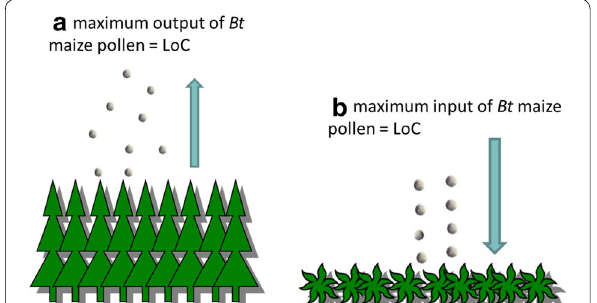
Fig. 3 Suggestions for the operationalisation of the LoC concept for non-target lepidopteran larvae and Bt maize. The LoC can be defined for the exposure-based indicators ( a ) “amount of Bt maize pollen released” or ( b ) “amount of Bt maize pollen deposited” in a specific environmental reference area (e.g. the field margin). For further explanation see